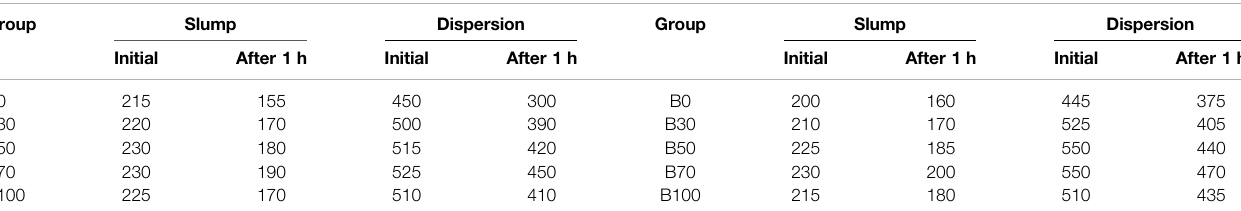
TABLE 7 | Slump and dispersion of concrete